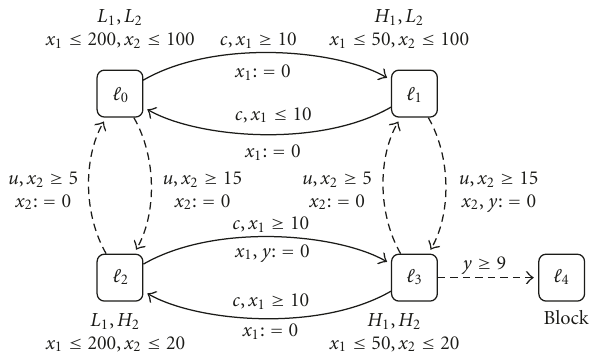
Figure 2: Timed game example: each x i is the clock , M L , m H , M H ) = (10,200,10,50) and for player i ; ( m L 1 1 1 1 , M L , m H , M H ) = (15,100,5,20); y is the clock for the ( m L 2 2 2 2 network; T =